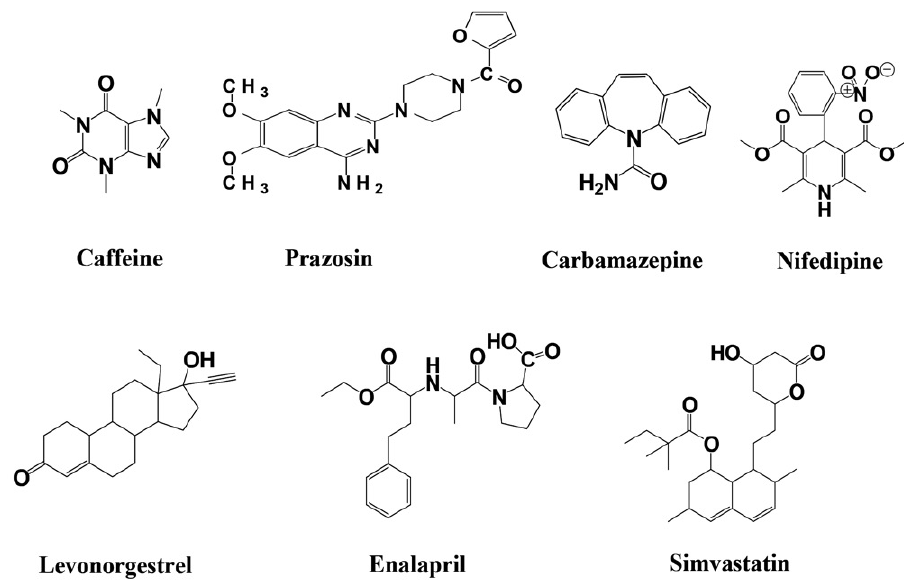
Figure 1. Chemical structures of seven pharmaceutical compounds